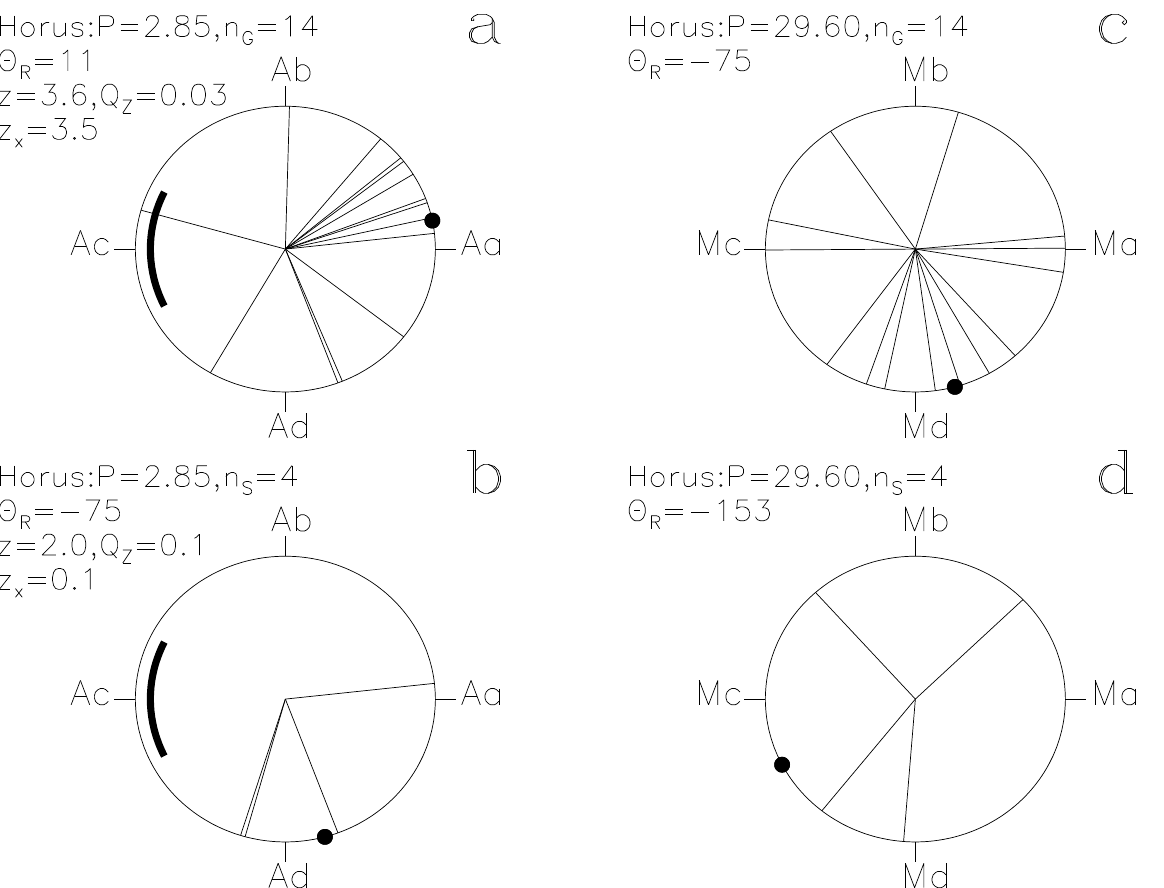
Fig 1. Horus. Time runs in the counter clock – wise direction on these unit circles. We give the z , Q z and z x values only when Q z (cid:6) 0.2. The large black point indicates the Θ R direction. (a) g i with Eq (11). Point Aa is at ϕ = 0 (cid:7) 0°. The thick line centered on point Ac at ϕ = 0.5 (cid:7) 180° outlines the proposed phase for the 10 hr eclipse of Algol. (b) s i with Eq (11). (c) g i with Eq (12). Point Ma at ϕ = 0 (cid:7) 0° is close to the proposed Full Moon phase. (d) s i with Eq